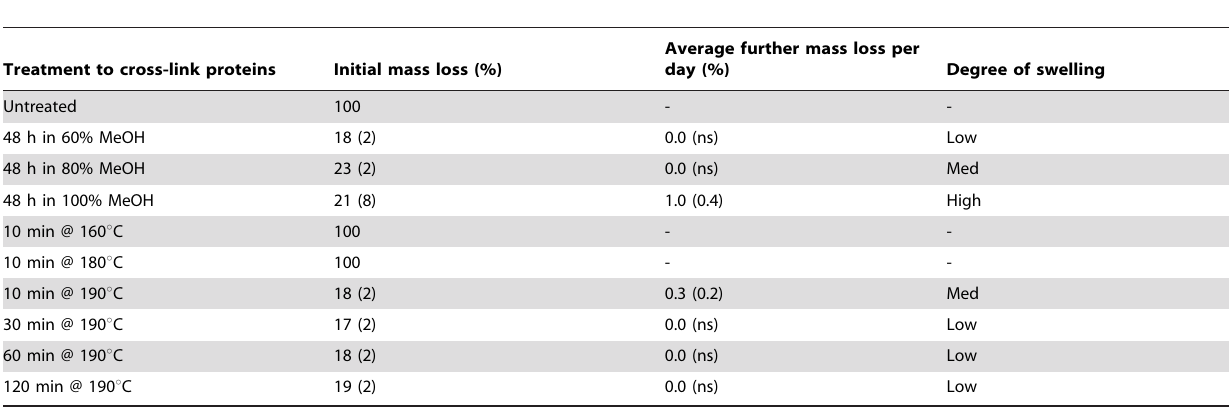
Table 1. Stability of honeybee silk sponges in water over 32 days. Standard deviations are given in brackets, ns=not significant at the 95% confidence